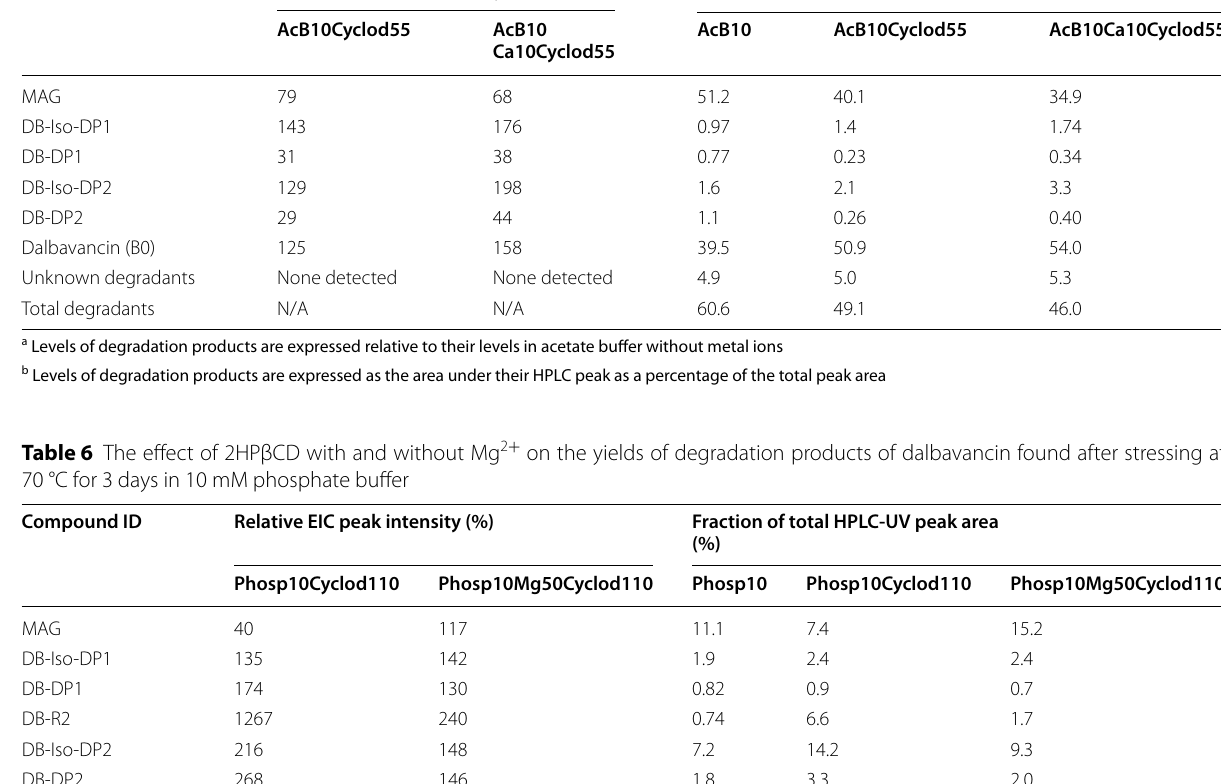
Table 5 The effect of 2HPβCD with and without Ca 2 + on the yields of degradation products of dalbavancin found after stressing at 70 °C for 5 days in 10 mM acetate buffer